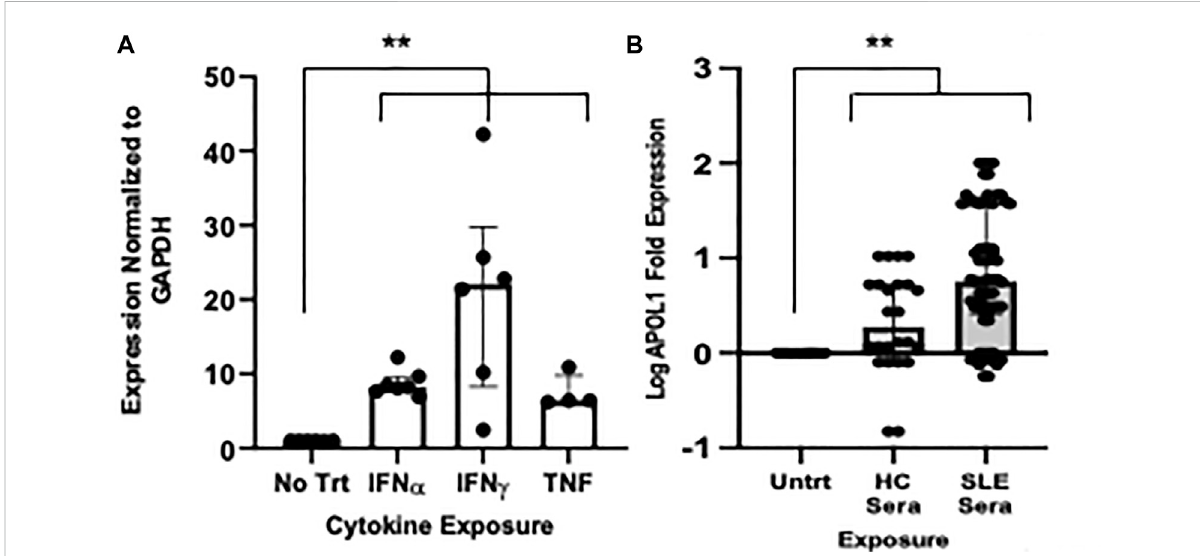
FIGURE 1 Endothelial cells treated with in fl ammatory cytokines induce APOL1 expression. (A) APOL1 expression in untreated HUVECs compared to IFN α (50 pg/ml),IFN ɣ (50 pg/ml),andTNF(10 ng)exposedfor18 h(averageof5experiments,9HUVECdonors).Shownonthe y -axisare2 − ΔΔ CT (transcript normalized to GAPDH) values and shown on the x -axis are cytokine exposures. (B) Exposure of HUVECs to sera at 1:1 dilution for 18 h resulted in an upregulation of APOL1 transcription (average of 5 experiments, 9 HUVEC donors). Shown on the y -axis are log 2 − ΔΔ CT (transcript normalized to GAPDH) values and shown on the x -axis are exposure conditions. Comparisons are made between the median fold expression in untreated vs. exposure conditions using Kruskal – Wallis tests (both 1A and 1B p < 0.02 as indicated by **) followed by post hoc Dunn test. Abbreviations: Untrt = untreated condition, IFN α = interferon alpha, IFN γ = interferon gamma, TNF = tumor necrosis factor, HC Sera = healthy control sera, and Systemic Lupus Erythematosus Sera = SLE Sera, experiments were run in